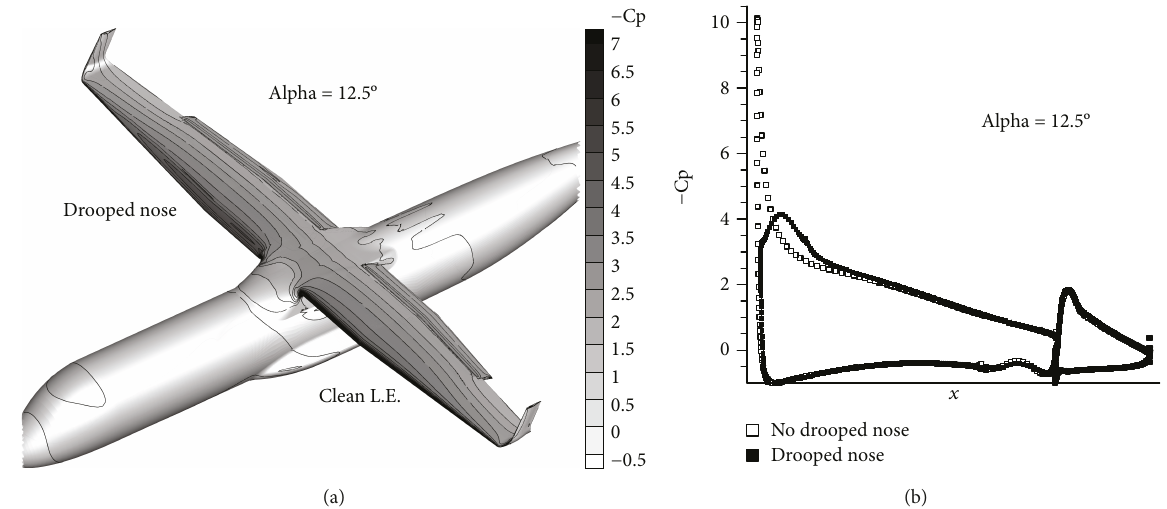
Figure 30: E ff ect of a droop nose on 3D Cp distribution (takeo ff , alpha = 12 5 °